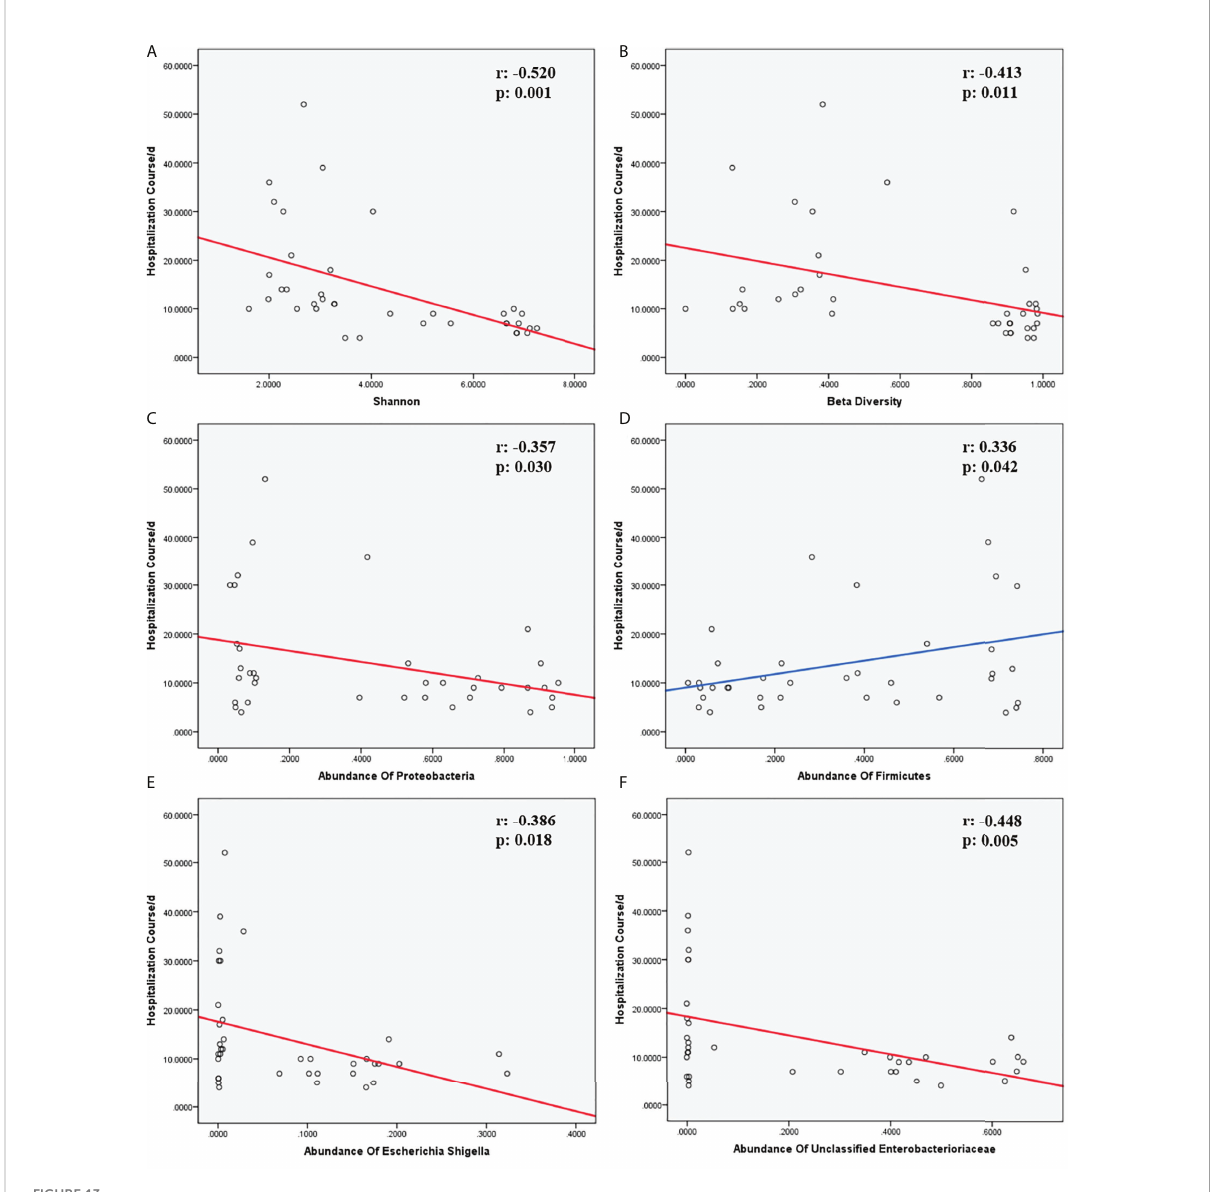
FIGURE 13 Correlation of hospitalization course and indicators. (A, B) were the correlation of a and b diversity and hospitalization course. (C, D) were the correlation of species and hospitalization course at the phylum level. (E, F) were the correlation of species and hospitalization course at the genus level. The r-value and p-value in Spearman correlation analysis were marked on the top-right corner in each chart. Fitting curves with a negative correlation were in red; fi tting curves with a positive correlation were in